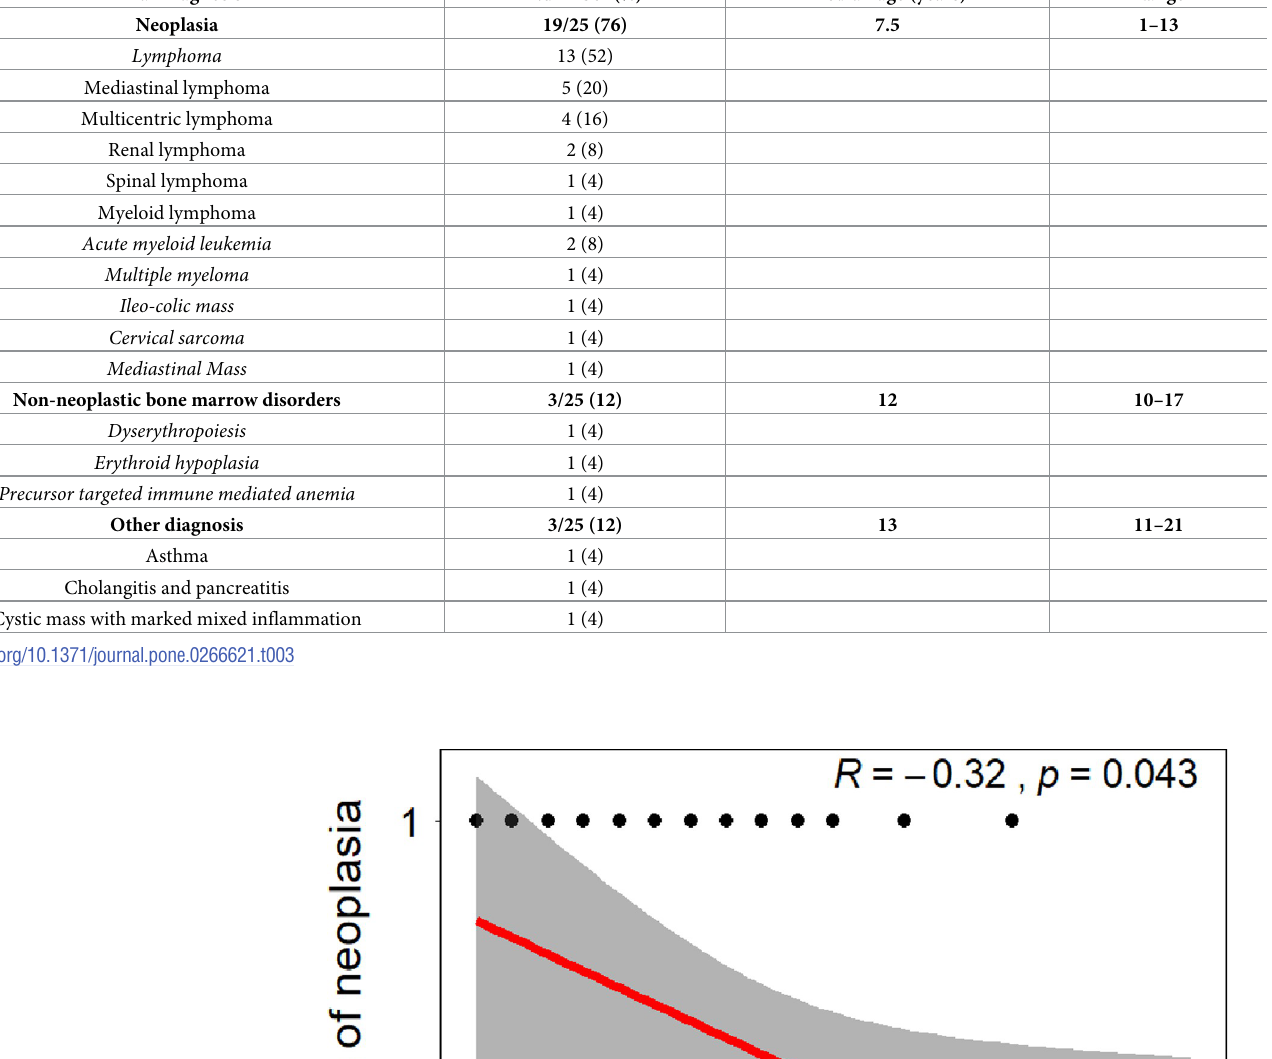
PLOS ONE | https://doi.org/10.1371/journal.pone.0266621 April 7,